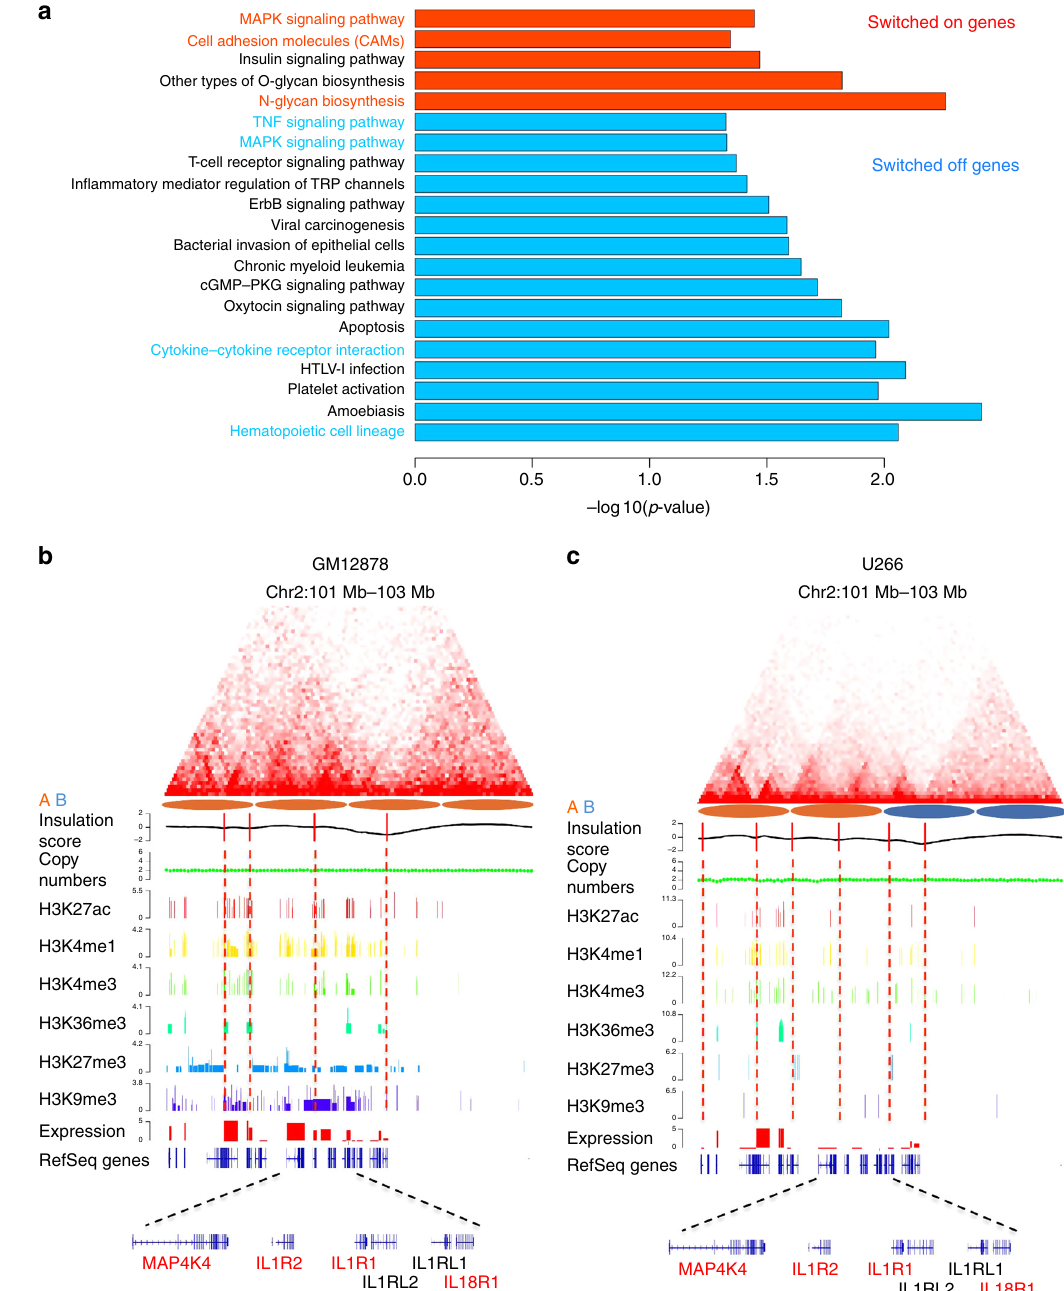
Fig. 5 The 3D structure and expression changes of multiple myeloma-related genes. a Gene pathway enrichment analysis for the switched on/off genes. Switched on genes are de fi ned when their genomic compartment changed from B to A in both MM cell lines (compared with GM12878). Switched off genes are de fi ned when their genomic compartment changed from A to B in both MM cell lines (compared with GM12878). Genes with mutations that affect protein coding were discarded. b Example of cytokine receptor gene cluster including IL1R1, IL1R2, IL18R1. The IL1R2 gene is located at chr2:101991844-102028544, and the plotted locus is from 1 Mb upstream to 1 Mb down-stream region surrounding the IL1R2 gene. Red color gene names indicate the genes that are enriched in the cytokine-cytokine receptor interaction pathway. In GM12878, IL1R1, IL1R2, IL18R1 and MAP4K4 were highly expressed. Insulation score, TAD boundaries (vertical red lines), copy numbers, ChIP-seq peaks of H3K27ac, H3K4me1, H3K4me3, H3K36me3, H3K27me3, H3K9me3, RNA-seq expressions and RefSeq gene tracks are shown below the Hi-C heatmaps. H3K4me3 is annotated as promoters, H3K4me1/H3K27ac as active enhancers, H3K36me3 as transcribed gene body and H3K9me3 as heterochromatin. c The same genomic region as in b using the data of U266 cells. The expression of IL1R1, IL1R2, IL18R1 and MAP4K4 are downregulated and the TAD boundaries are altered, accompanied by reduced epigenetic marks such as H3K27ac, H3Kme1 and